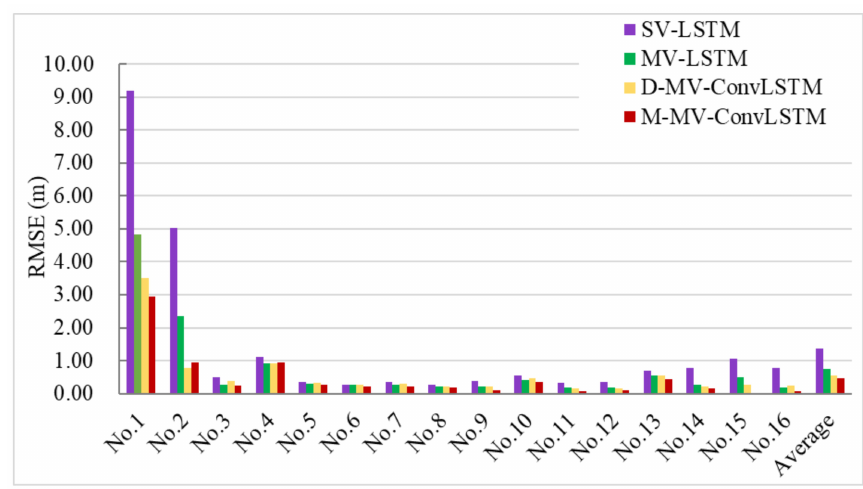
Figure 6. RMSE values obtained at the 16 wells in the four experiments. Table 4. RMSE and NSE values of the GWL prediction results obtained from the four experiments at 16 wells.